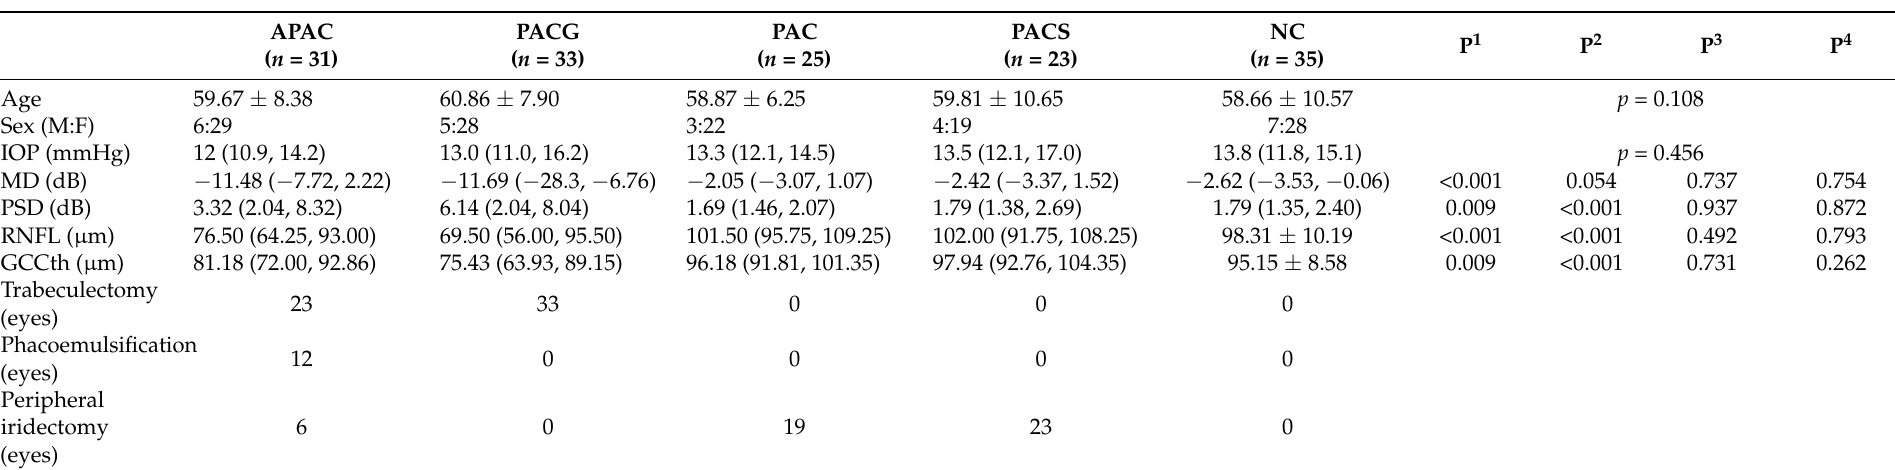
Table 1. Demographical and clinical characteristics of the participants.